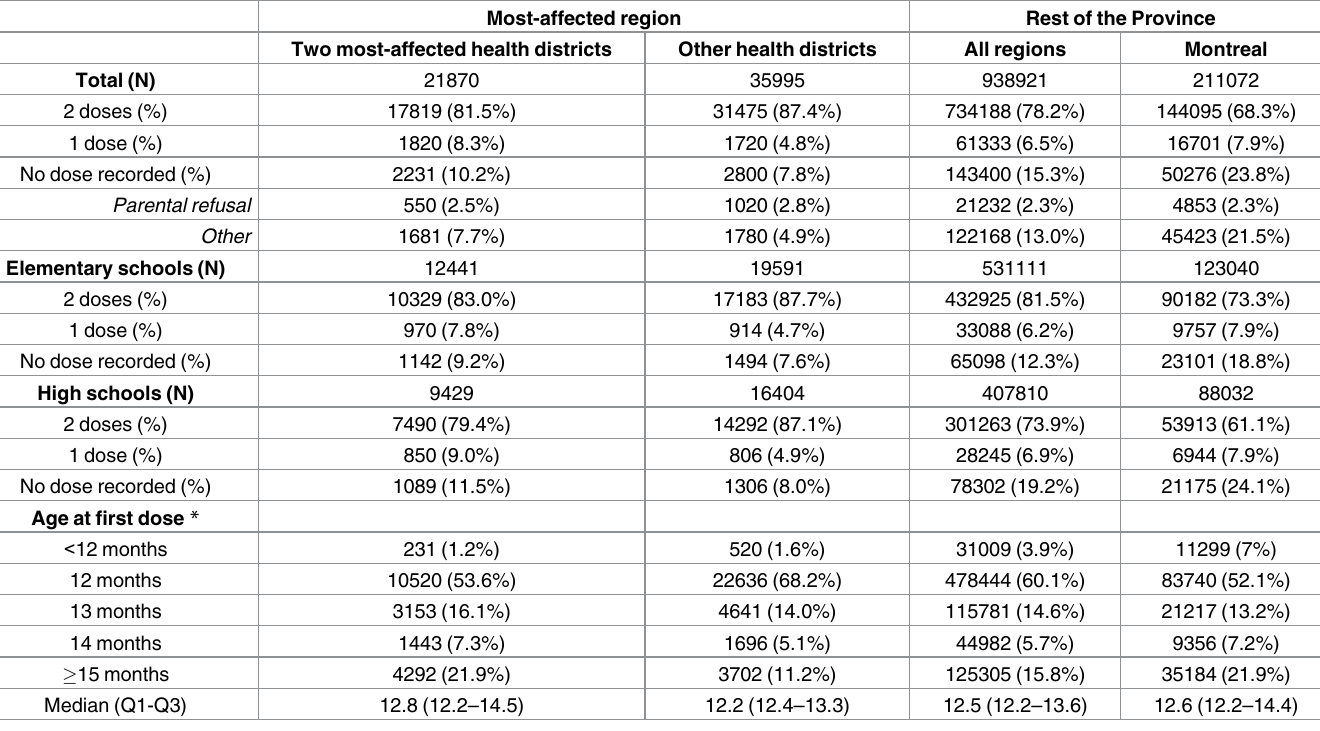
Table 2. Age at first dose of measles vaccine and vaccine coverageamong elementary students, high school students and the whole student pop- ulation according to the geographic area of residence in May 2011, before the outbreak. Most-affected region Rest of the